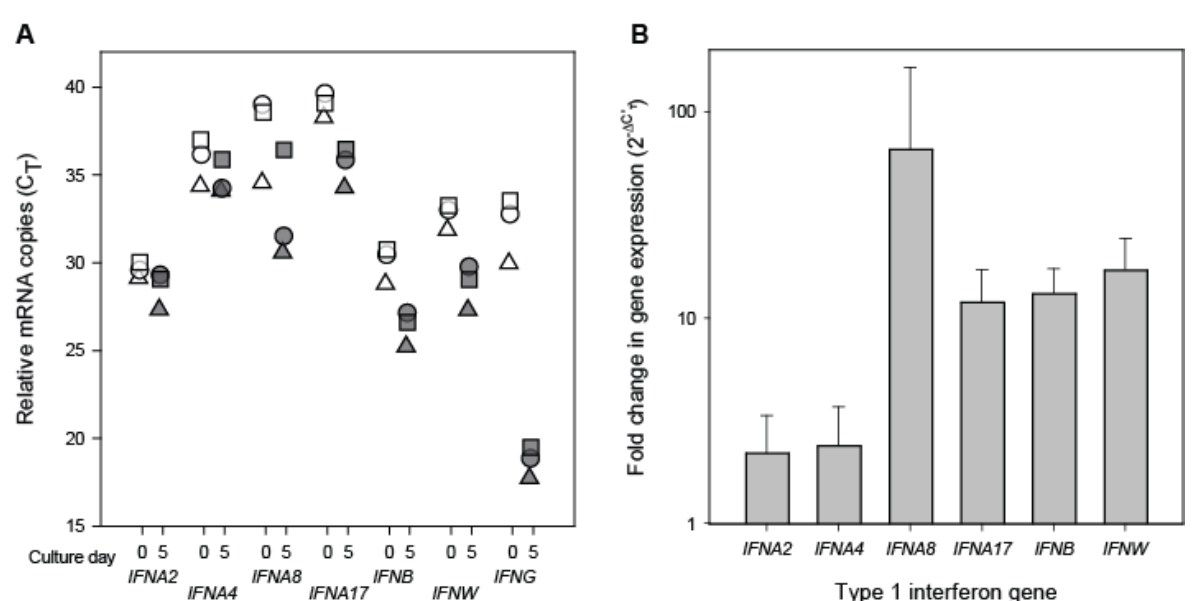
Figure 3. Interferon transcript levels in resting and stimulated CD8+ cells . Relative levels of type 1 interferon ( IFNA2 , IFNA4 , IFNA8 , IFNA17 , IFNB , and IFNW ) and type 2 interferon (IFNG) mRNA transcripts were measured by qRT-PCR. ( A ) Shown are the C T values for each transcript measured in resting (open symbols) and stimulated (shaded symbols) CD8+ T cells from 3 different donors. ( B ) Shown are fold-changes (means and standard deviations) in the expression of type 1 interferon transcripts upon stimulation of the CD8+ T cells and measured at day 5 of the cell culture.